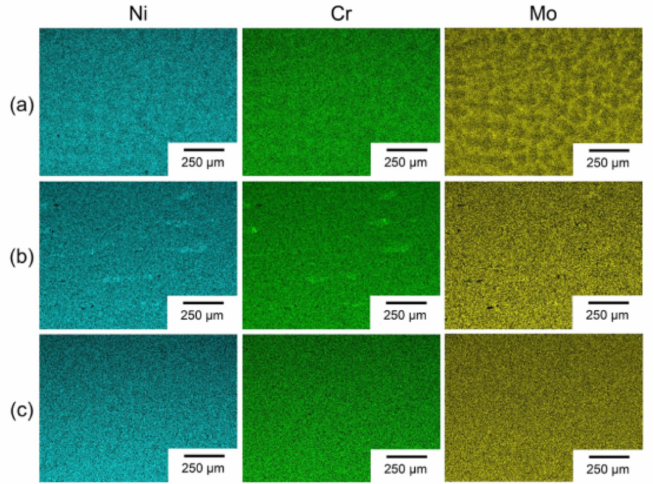
Figure 5. EDS images of Ni–Cr–Mo alloys (magnification = 100 × ): LWC ( a ), SLM ( b ), and SMM ( c